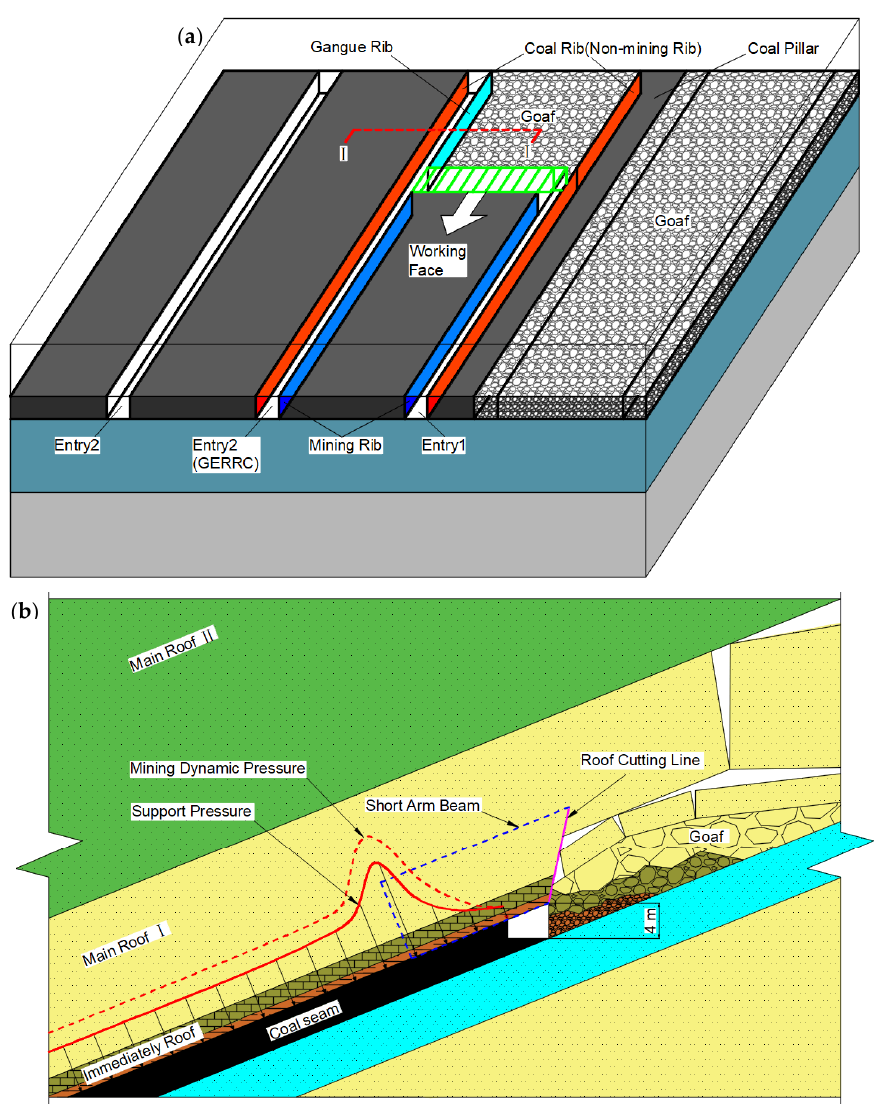
Figure 1. GERRC. ( a ) 3D view of GERRC; ( b ) profile view of I-I.